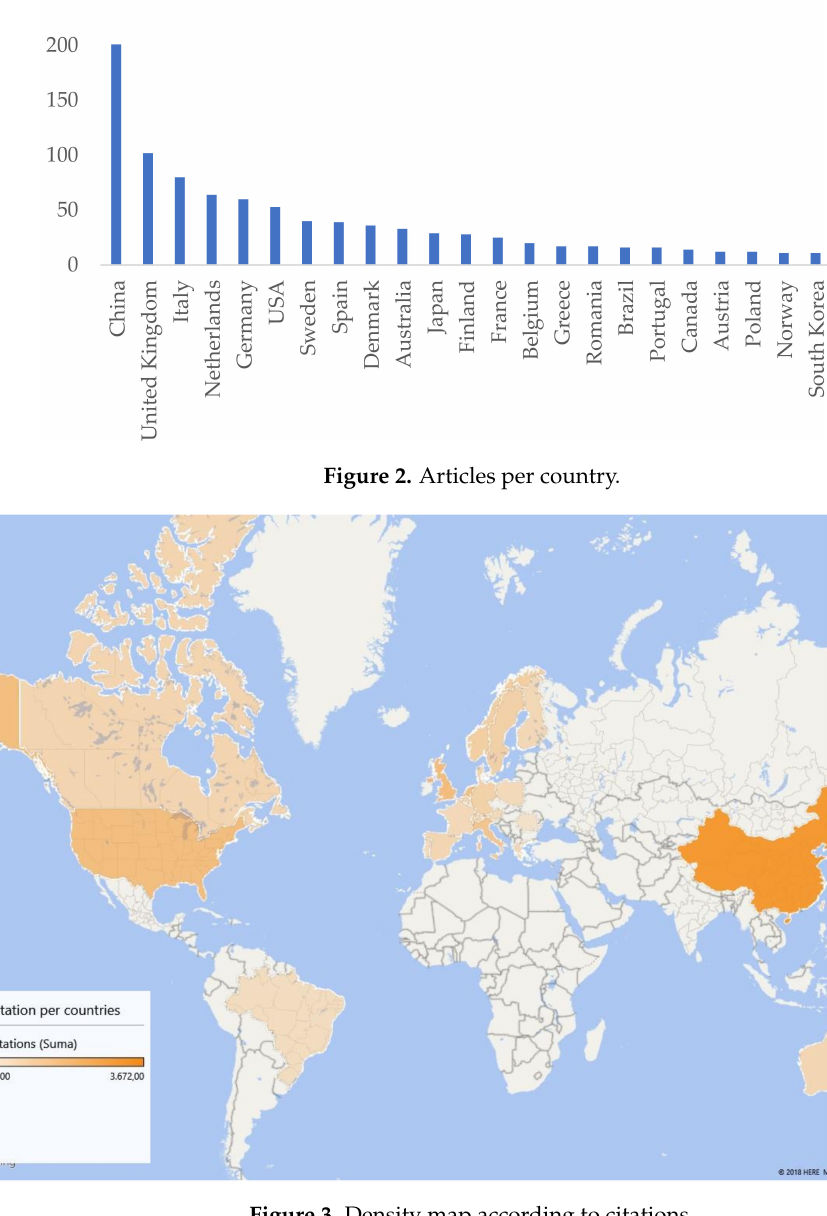
Figure 3. Density map according to citations. Table 2. Languages used in scientific articles about circular economy and